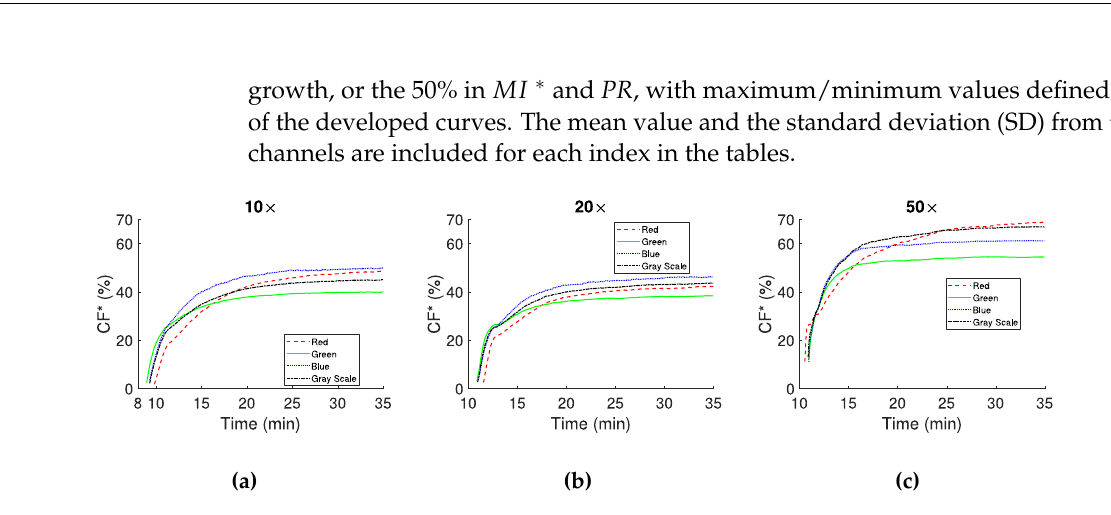
Figure 7. CF ∗ expressed as percentage of the image area that is occupied by clots for the three magnifications (10 × ( a ), 20 × ( b ) and 50 × ( c )). Table 2. Clot start time (CS), characteristic coagulation time (CT) and sensitivity index (SI) for mean intensity ( 𝑀𝐼 ∗ ), plasma reduction ( PR ) and clot formation ( 𝐶𝐹 ∗ ) in the 10 times objective case.